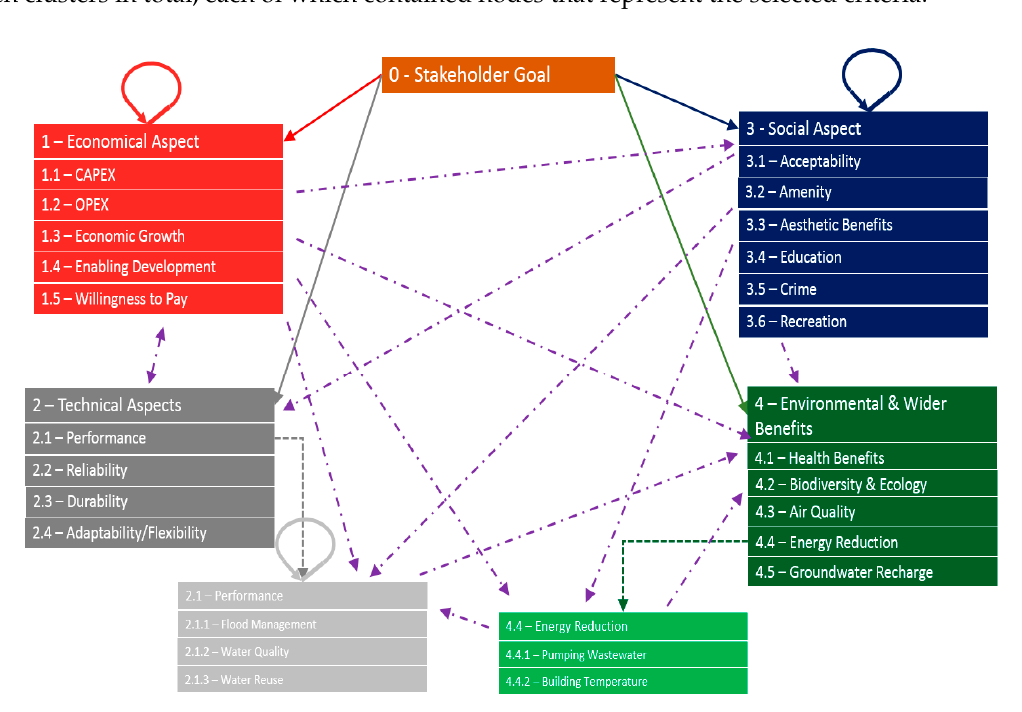
Figure 3. Example ANP network structure for SuDS stakeholders’ priorities assessment. The connections with the stakeholders ‘goals are represented by a continuous line; the connections of the main criteria with the sub-criteria are represented by a dashed line; and the interactions among the criteria are represented by a dashed dot line. The loops indicate inner dependence among the elements in the cluster. ANP, Analytic Network Process; CAPEX, CAPital Expenditure; OPEX, OPerating